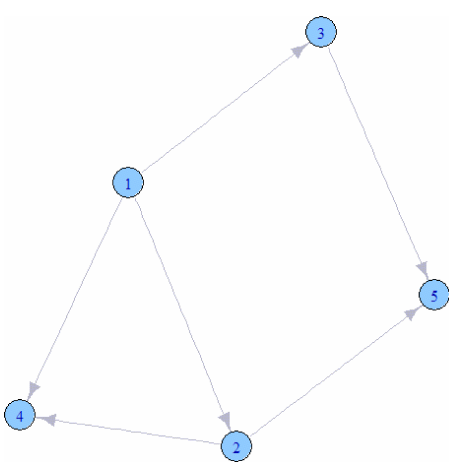
Fig. 1. An example of Bayesian